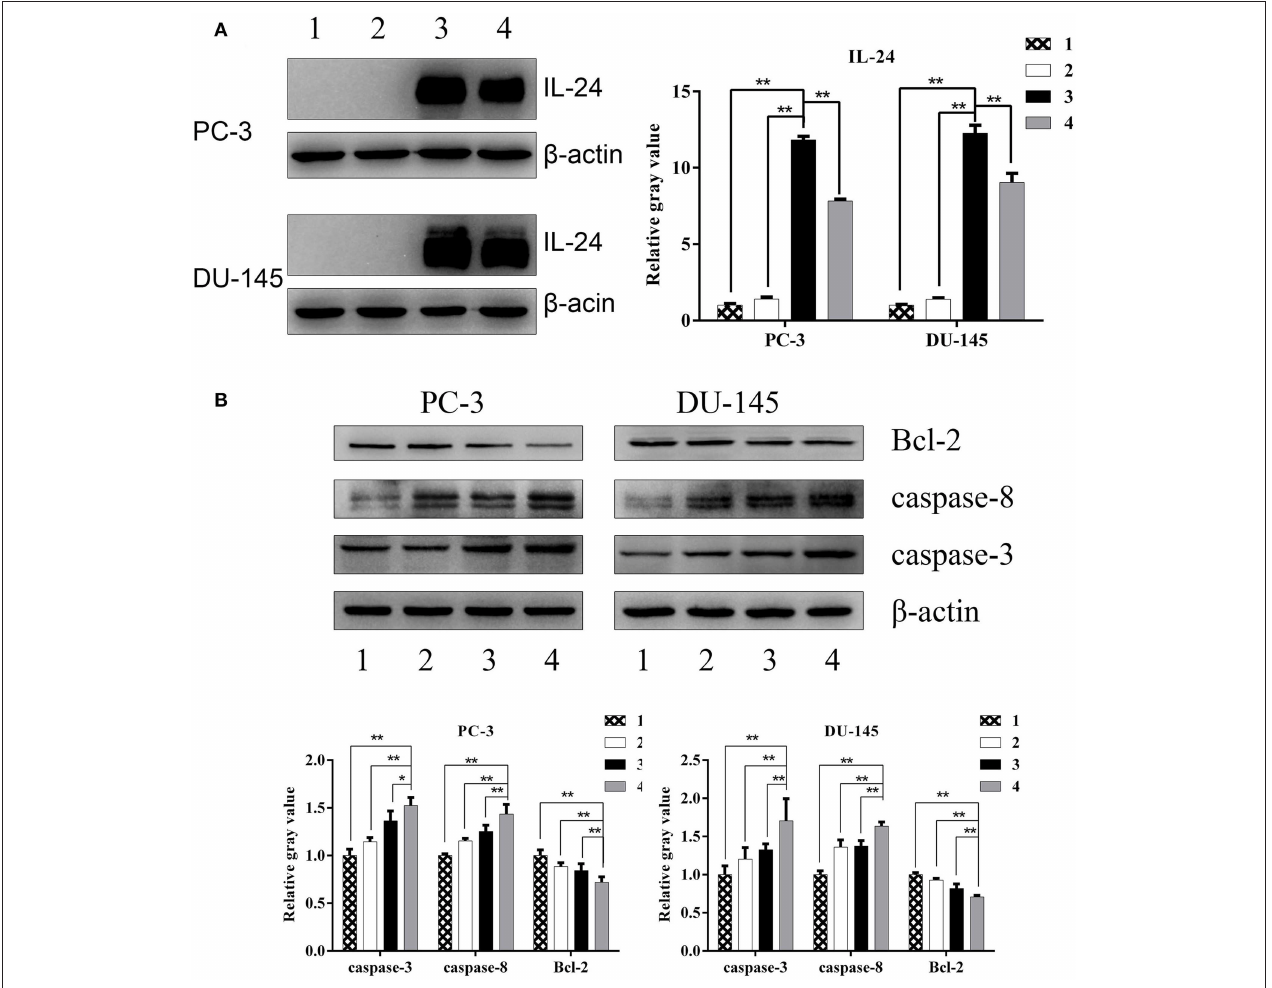
FIGURE 3 | The expression of apoptosis related proteins in PC-3 and DU-145 cells exposed to ZD55-IL-24 or/and radiation. (A) Western blot analysis of IL-24 protein levels in PC-3 and DU-145 cells in each group. (B) Western blot analysis of Bcl-2, caspase-3, and caspase-8 protein levels in PC-3 and DU-145 cells in each group. 1, PBS; 2, radiation; 3, ZD55-IL-24; 4, combination of ZD55-IL-24 and radiation. * P < 0.05, ** P < 0.01 vs. combination group.